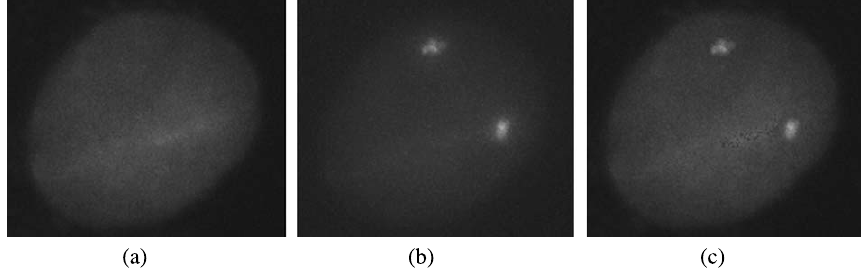
Fig. 5. An example of an integrated fusion image (c) obtained from the sharpest cell image in the first cell targeted spectrum (a) and a 2-D projection image (b) obtained from in the second FISH signal targeted